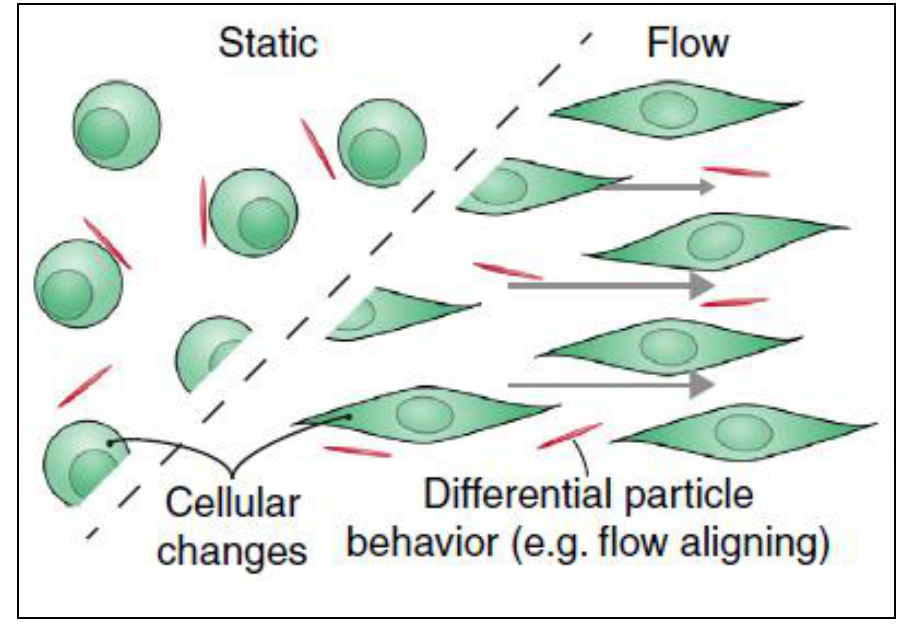
Figure 6. Filamentations or 2D nanomaterials align differently when there is fluid flow in cancer microenvironment. This flow-aligning effect can change the way that the cells interact with nanoparticles thus their cellular uptake would be influenced. Adapted from Björnmalm et al. [41].